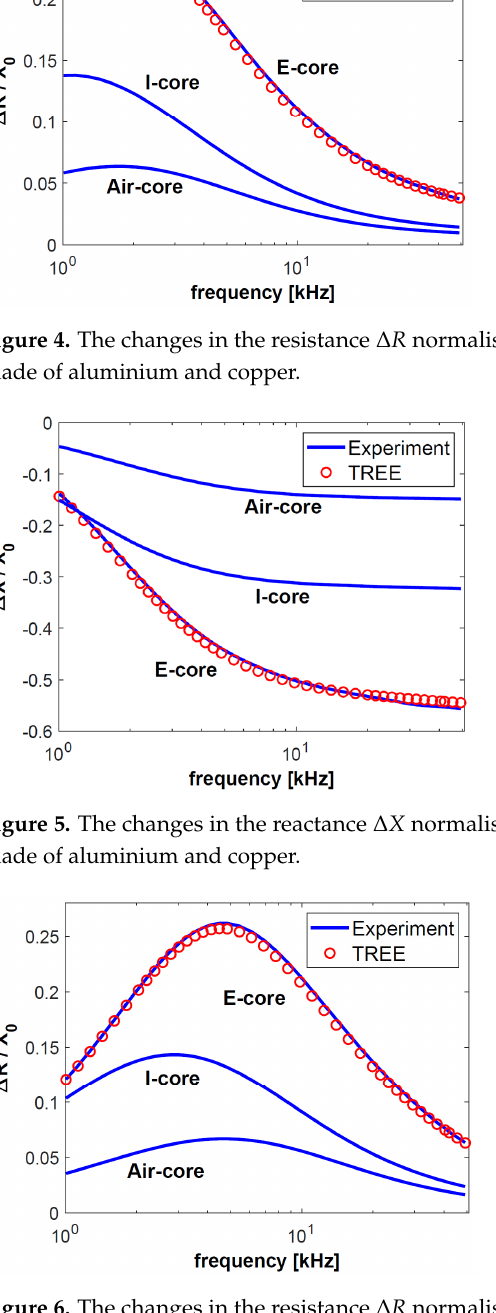
Figure 7. The changes in the reactance Δ X normalised with respect to the reactance X 0 for sample made of brass and copper. In the next step, the possibility of using the proposed analytical model for thermal barrier coating tests was examined. For this purpose, coatings with parameters corre- sponding to TBC utilised to protect turbine blades were modelled. The substrate had a thickness of 2 mm and a conductivity of 0.5 MS/m, and the bond coat was 0.1 mm and 0.15 MS/m, respectively. The 0.2-mm-thick top coating was nonconductive. The finite element method was used to verify the obtained results. The numerical model created in Comsol Multiphysics consisted of 31,540 triangular elements, 16,982 mesh vertices, 5925 boundary elements and 30 vertex elements. The normalised values of changes in the impedance components of the pot-core sensor for frequencies ranging from 1 kHz to 1 MHz are shown in Figure 8.